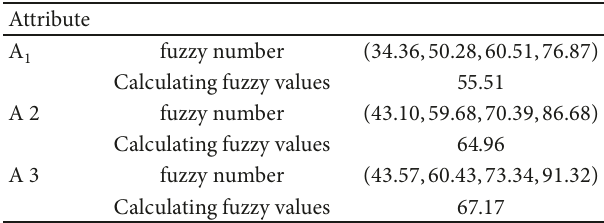
Table 9: The scores